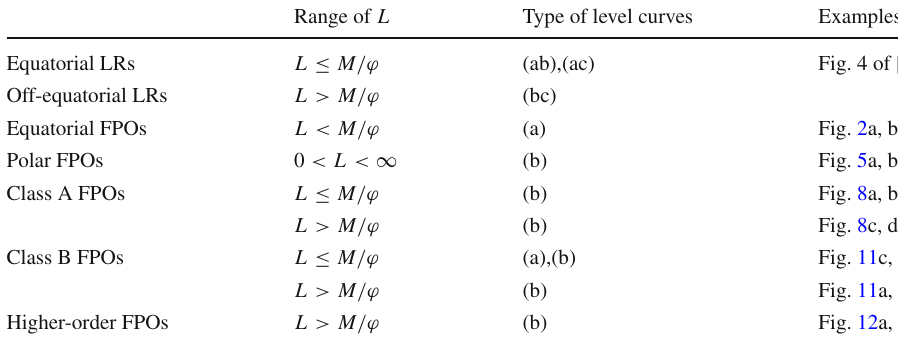
Range of L Type of level curves